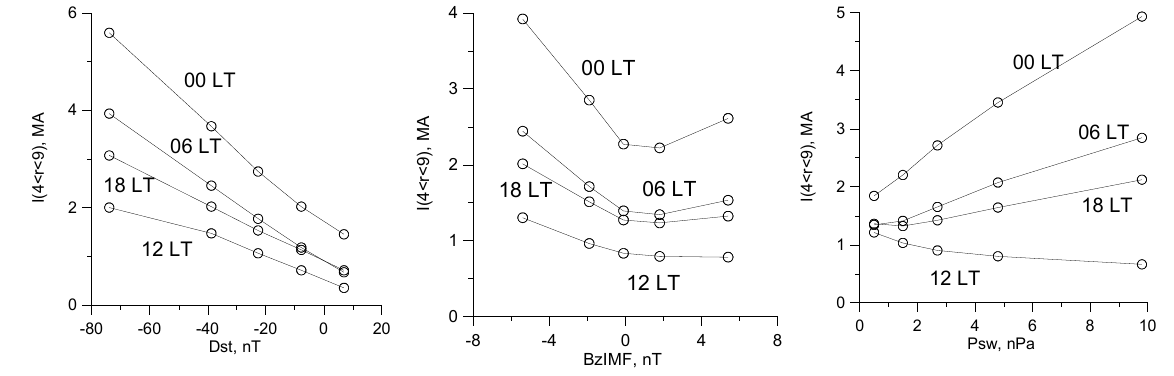
Fig. 6. The same as in Fig. 3 but for the model by Tsyganenko (2002a, b).